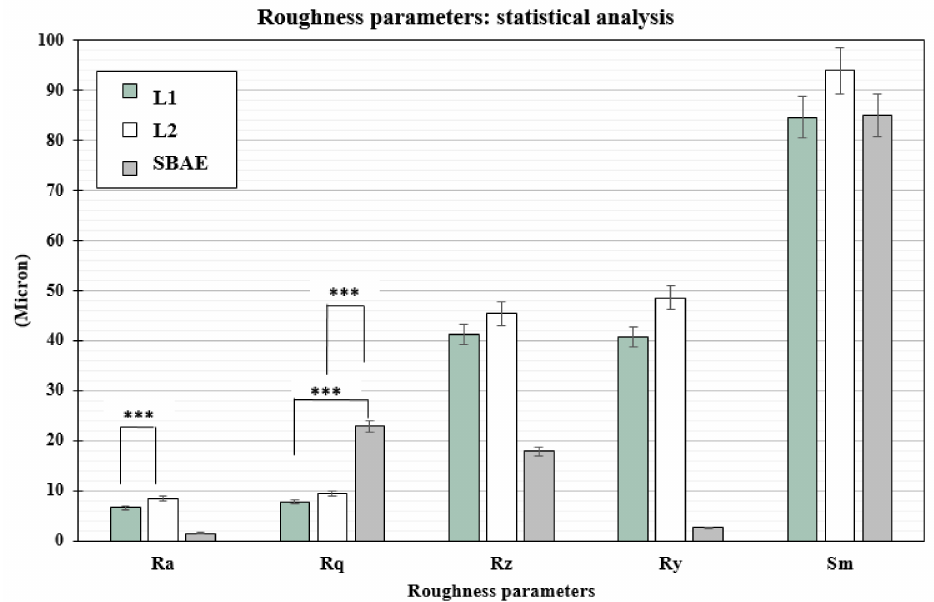
Figure 4. t -test statistically significance relationship between the profilometric data recorded: p - values ≤ 0.005 was considered positive. Ra of L1 vs. L2 (0.0013), and Rq of L1 vs. SBAE (0.0001) and L1 vs. SBAE (0.0001), showed surface textures statistically significant differences (*** p ≤